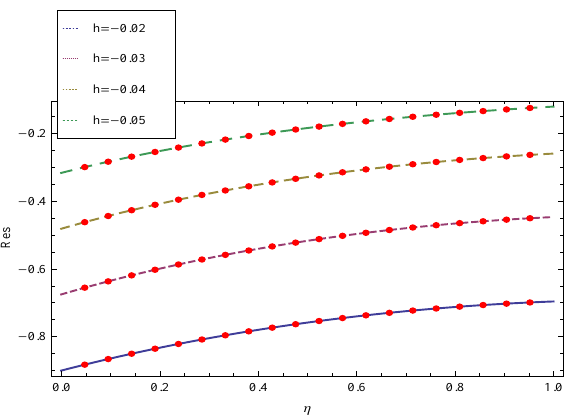
Figure 31. Shows h curves of the residuals for the concentration profile φ ( η ) , when λ = 0.6, s = 0.6; Kr = 0.4, Pr = 1,Ec = 0.4,Nb = 0.6,Nt = 0.5,sc = 0.5, β = 1.